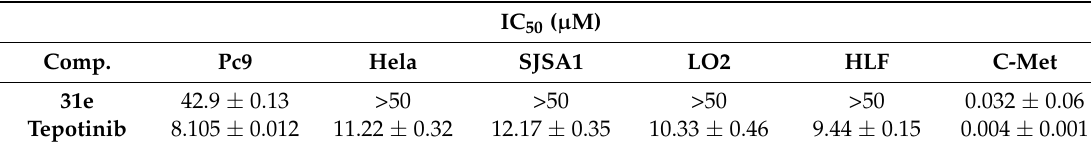
Table 2. The inhibitory activity of compound 31e against cancer cells (97H, Pc9, Hela, SJSA1), human normal cells (LO2 and HLF), and c-Met enzyme.